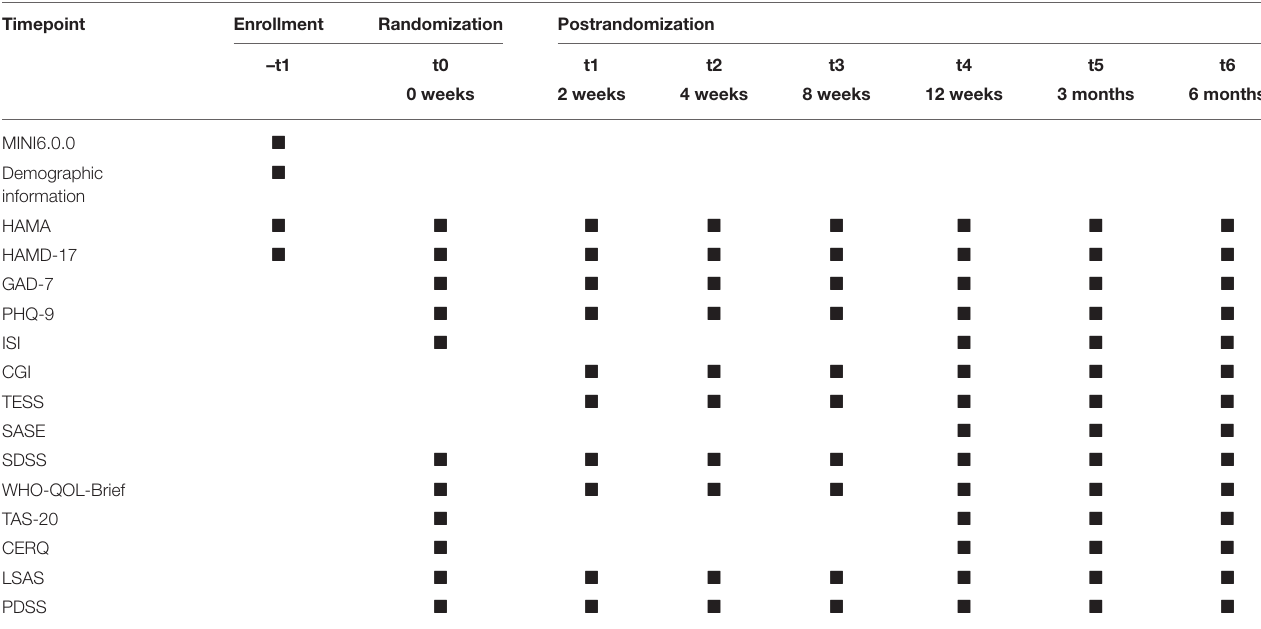
TABLE 1 | Study assessment tools and assessment time schedule. Timepoint Enrollment Randomization